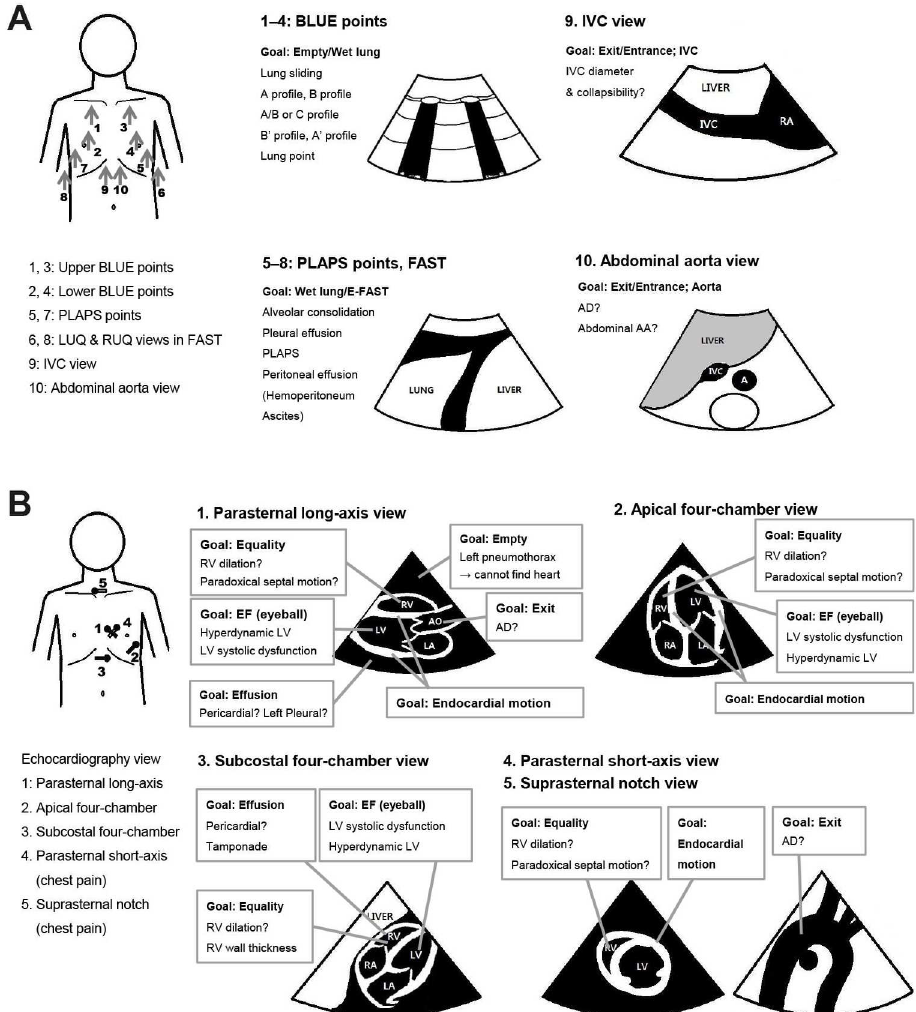
Fig 2. Schematic drawing of transducer, the image planes and key points in the SEARCH 8Es protocol. The performance sequenceof SEARCH 8Es was dividedinto two steps. (A) The first step of ‘SEARCH’ with the convex probe to search for the pneumothorax, interstitial syndrome (pulmonaryedema, ARDS, interstitial disease),pneumonia,pleuraleffusion, peritonealeffusion, abdominal aortic aneurysm, aortic dissection,or a clue of hypovolemia. The convex probe is locatedlongitudinally on the anterior chest and posterolateral chest to examinewhether there are any findings that are suggestiveof empty thorax, edematous or wet lung and free fluid aboveand below the diaphragm.In cases of intraperitoneal fluid, the probe is placedin the same manner as the conventional FAST. The convex probe is used to evaluate the lungs, the abdomenand to look at the IVC. The A profile is definedthe conditions appearedlung slidingwith A line in both lungs. The A’ profile is an A profile without lung slidingand lung point. The B profile is definedto anterior-predominantbilateral B lines associatedwith lung sliding. The B’ profile is a B profile without lung sliding.The A/B profile is definedto anterior predominant B lines on one lung and predominant A lines on the other. The C profile is definedto anterior alveolarconsolidation(s). (B) The 2 nd step of ‘SEARCH’ with the cardiacprobe to search for pericardialeffusion with or without tamponade physiology(diastolic right ventricle collapse), pulmonary embolism(right ventricle enlargement, paradoxical interventricular septal movement), left ventriclesystolic dysfunction, acute myocardialinfarction (left and right ventricularregionalwall motion abnormality) and it’s mechanical complications (papillarymuscular rupture, left ventricle wall rupture), and a clue of a hypovolemicor distributive shock (hypokinetic small-sized left ventricle or hyperkinetic normal-sized left ventricle). In case of chest pain, parasternal short axis view and suprasternalnotch view was performed due to the evaluation of regionalwall motion and thoracicaorta dissection or aneurysm. If the apical 4 chamber view is difficult due to poor window,a subxiphoid view is used. AAA, abdominal aortic aneurysm; AD, aortic dissection; ARDS, acute respiratory distress syndrome; BLUE, bedsidelung ultrasoundin emergency; EF, ejectionfraction; E-FAST, extendedfocused assessment with sonography for trauma; FAST,